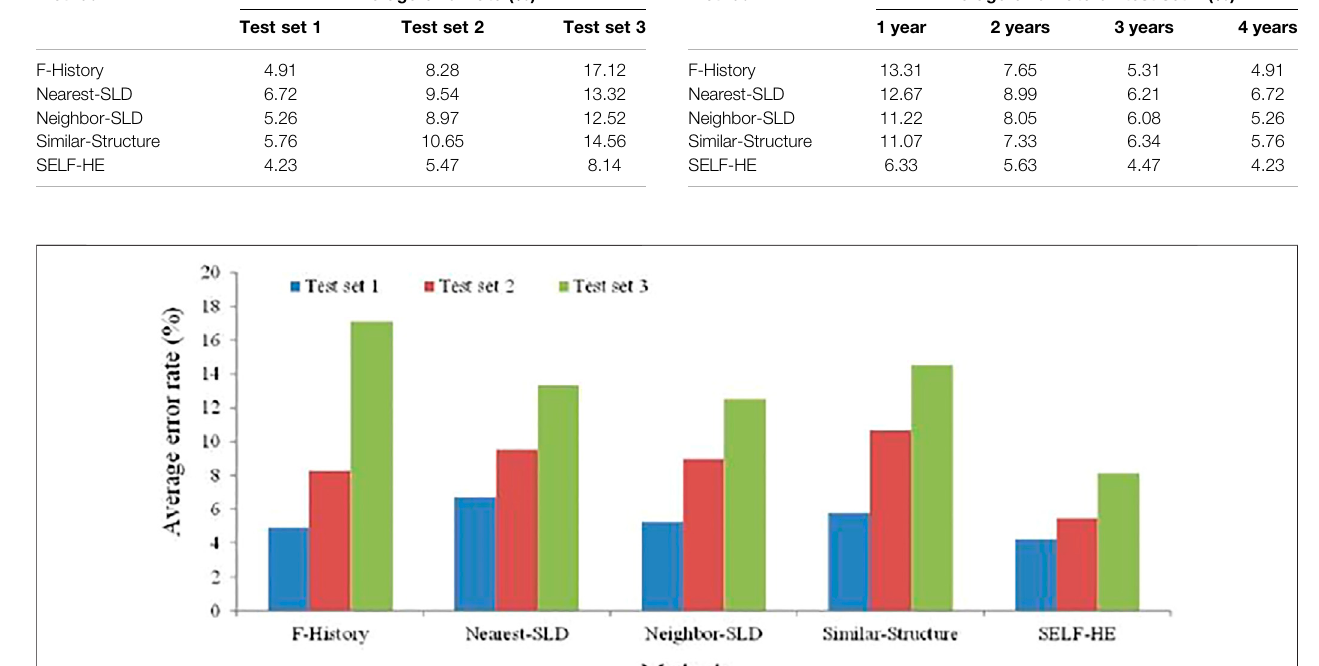
FIGURE 9 | Comparison of the fi ve methods.